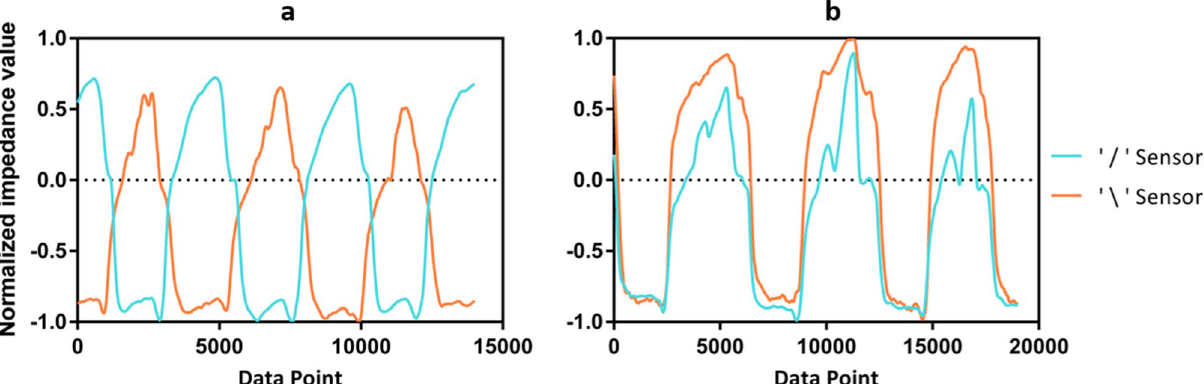
Figure 6. ( a ) Sample data collected from horizontal range motion ( b ) Sample data collected from vertical range